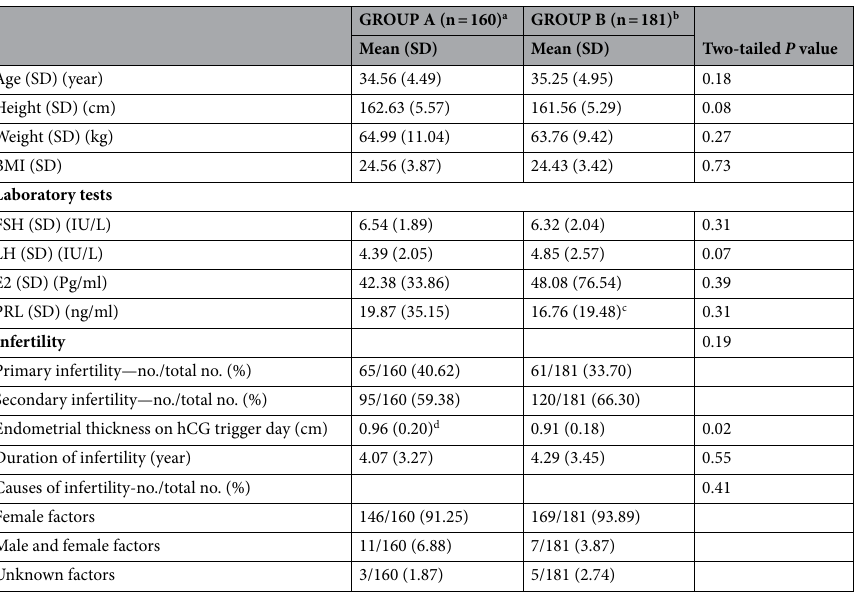
Table 1. Comparison of baseline data of the two groups. a In the study group (n = 160), GnRH-a was added based on GnRH-a before hormone administration to adjust the menstruation cycle. b The control group (n = 181) was treated only with an artificial hormone cycle to prepare the endometrium. c One value was missing. d Five values were